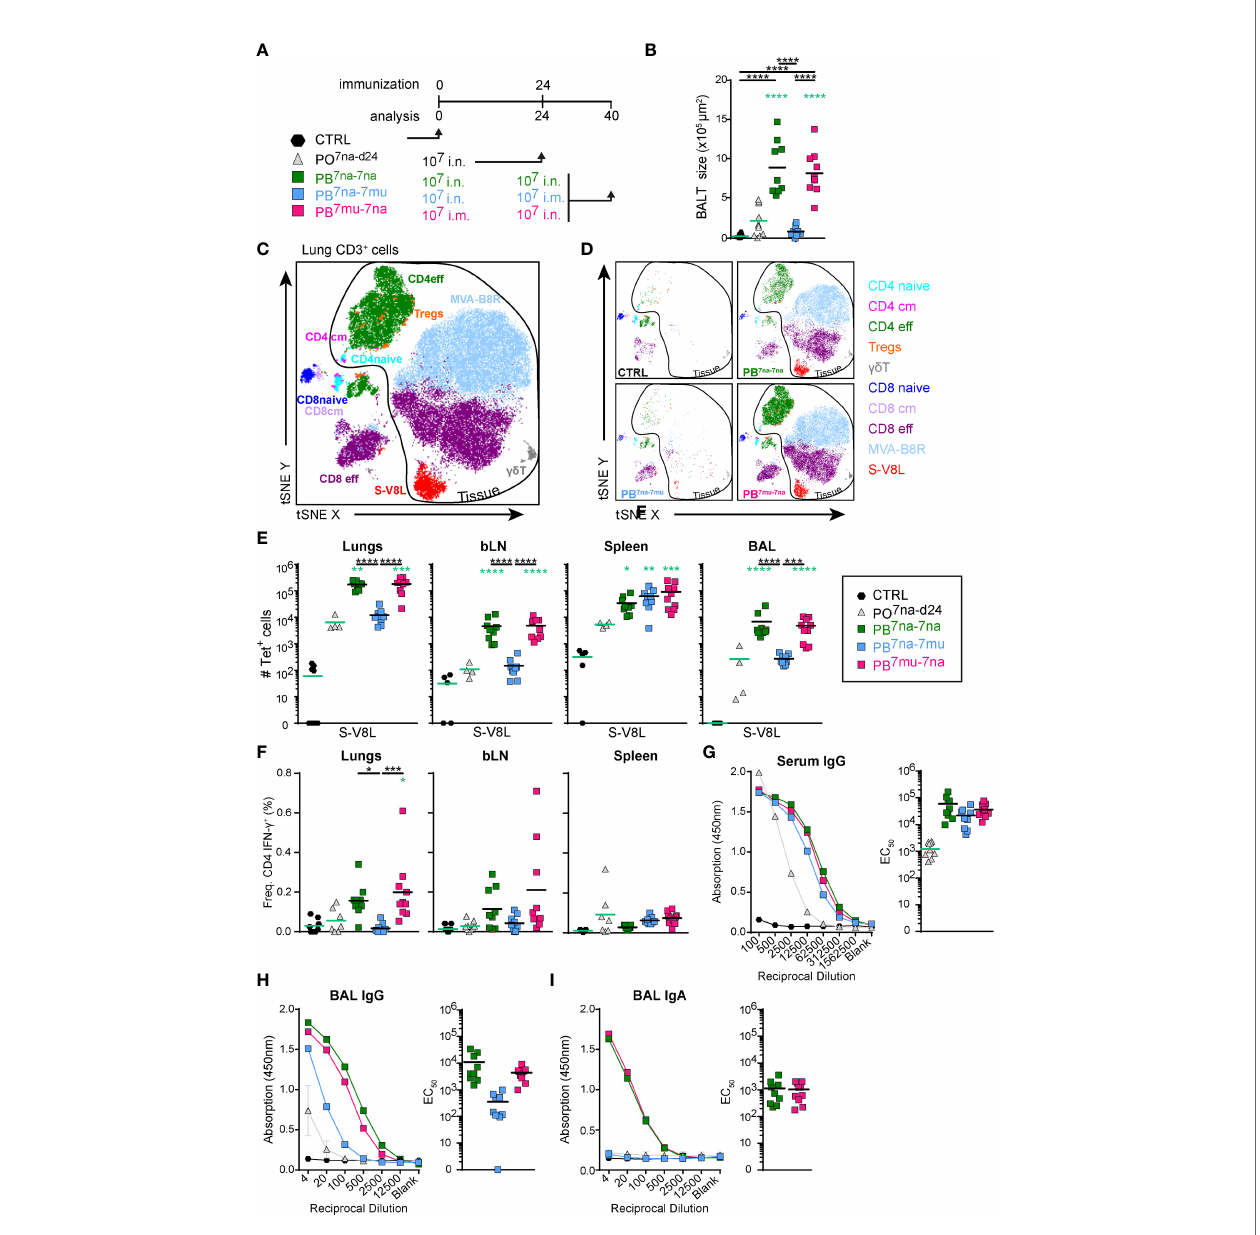
FIGURE 3 | Intranasal boost with MVA-SARS-2-S induces strong local and systemic cellular immune responses irrespectively of the route of priming. (A) Immunization protocol scheme. (B) Cumulative size of BALT structures averaged on 3-4 central lung sections per mouse. (C, D) Composition of lung CD3 + T cells analyzed by spectral fl ow cytometry and depicted as tSNE plot. Cluster identities were revealed by manual gating as shown in Supplementary Figure 2 ; antibodies used are listed in Supplementary Table S1 (panel 3). Cells inside the area delineated by the black line were negative for anti-CD45-FITC antibodies i.v. injected 3 -5 min. before mice were sacri fi ced and are thus considered to be from the lung parenchyma. Cells outside that area were CD45-FITC + and considered to be within or in close vicinity to blood vessels. (C) tSNE plot of concatenated FCS fi les from one representative mouse of each prime-boost group immunized with 10 7 PFU vaccine and one non-immunized control mouse. (D) Individual tSNE plots of de-concatenated FCS fi les from (D) . (E) Absolute counts of CD8 + T cells speci fi c for S- V8L evaluated by tetramer staining in tissues and groups indicated. (F) Frequencies of IFN- g + CD4 T cells in organs indicated determined by intracellular cytokine staining after re-stimulation with the pool of S 1-129 together with immnodominant peptides and brefeldin A ( Supplementary Table S2 ) for 6hr. (G) Spike-speci fi c antibodies in serum and (H, I) BAL determined by ELISA. Mean OD group values of serial serum and BAL dilutions and individual EC 50 values for Spike-speci fi c IgG in serum (G) and BAL (H) and Spike-speci fi c IgA in BAL (I) are shown for the groups indicated analyzed at day 40. Pooled data from 3-4 experiments with n = 10 per group. (B,E – I) Individual values (signs) and mean group value (line). Statistical analysis was done on log-transformed values using ordinary or Welch ’ s ANOVA followed by Dunnett ’ s T3 multiple comparisons test. Green stars - difference to the mice immunized with PO 7na-d24 ; Black stars - difference between different treatment groups as indicated with line. *p < 0.05, **p < 0.01, ***p < 0.001, ****p < 0.0001. (B, E – I) Data from control mice and mice immunized with 10 7 IU MVA- SARS-2-S are identical to that shown in Figure 1C ; (B, D – F)